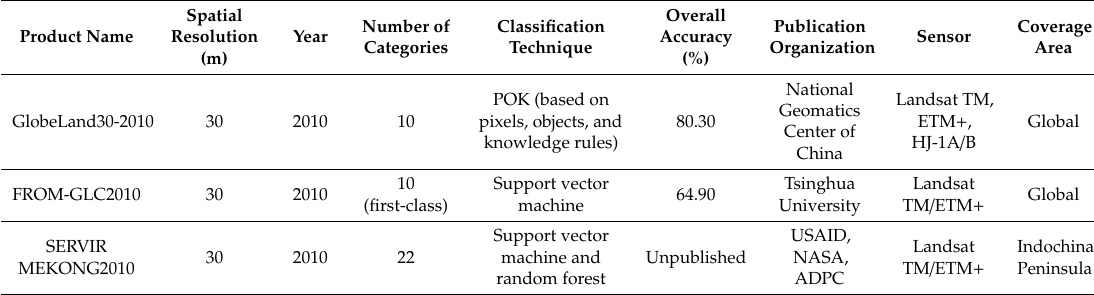
Table 1. Main parameters of three kinds of land cover